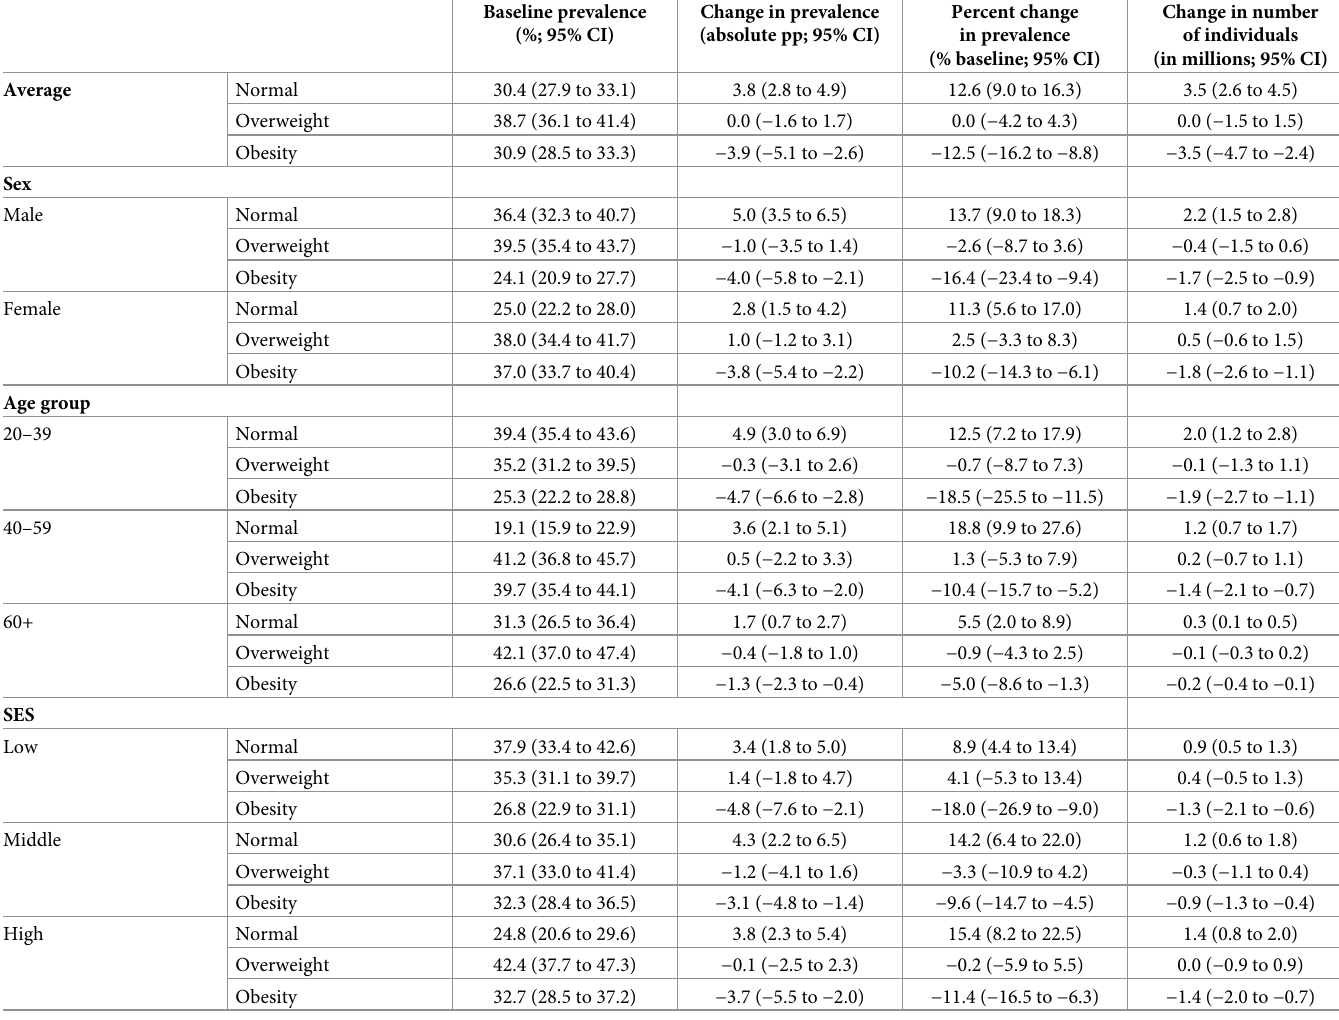
Table 3. Predicted change in absolute and relative prevalence and absolute number of individuals for normal, overweight, and obesity after 12 years of the imple- mentation of a 50% gradual reduction of added sugar in SSBs, considering a 43% compensation (data projected to year 2032).